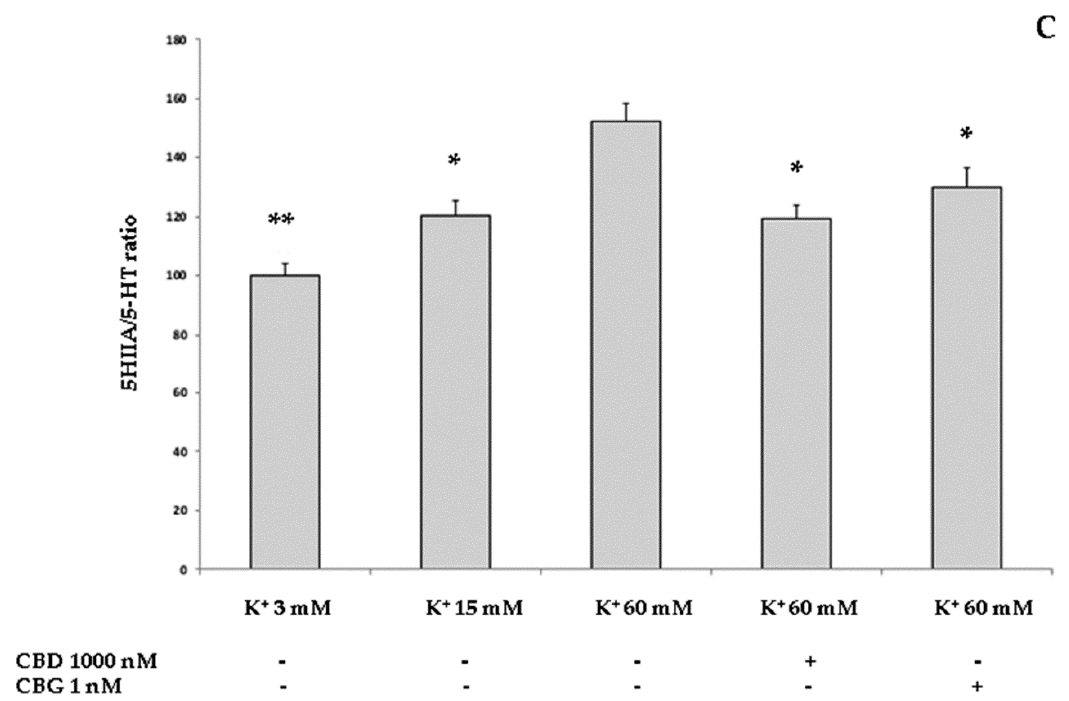
Figure 6. E ff ects of CBD 1000 nM and CBG 1 nM on K + 60 mM-induced increase in 3-HK level (expressed as ng / mg wet tissue; Panel ( A ), reduction in kynurenic acid (KA) level (expressed as ng / mg wet tissue; Panel ( B ), and increase in 5-HT turnover (measured as 5HIIA / 5-HT ratio, Panel C ) in isolated rat cortexes ( n = 3 for each experimental condition). Panel A: ANOVA, p < 0.001, F = 41.26; post hoc test, ** p < 0.01, *** p < 0.001 vs. K + 60 mM group. Panel B: ANOVA, p < 0.001, F = 91.51; post hoc test, *** p < 0.001 vs. K + 60 mM group. Panel C: ANOVA, p < 0.001, F = 32.37; post hoc test, * p < 0.05, ** p < 0.01 vs. K + 60 mM